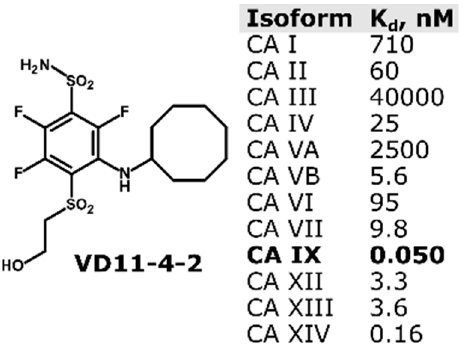
Figure 1. Chemical structure of compound VD11-4-2 and its dissociation constants according to the data provided in [19].